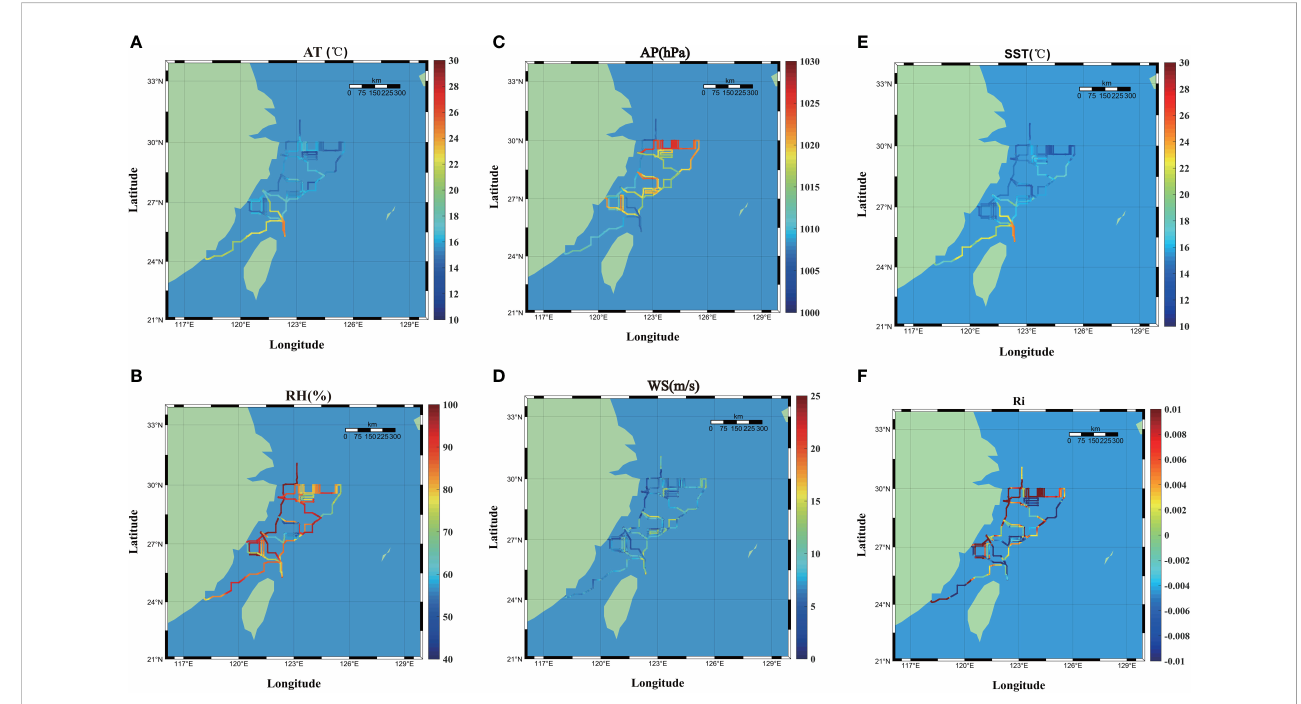
FIGURE 7 Statistical analysis of the observation data in the spatial dimension. (A) AT; (B) RH; (C) AP; (D) WS; (E) SST; (F)